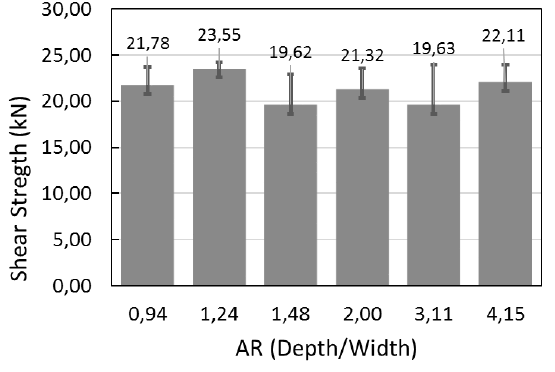
Figure 11. Lap shear strength for different AR grooves.